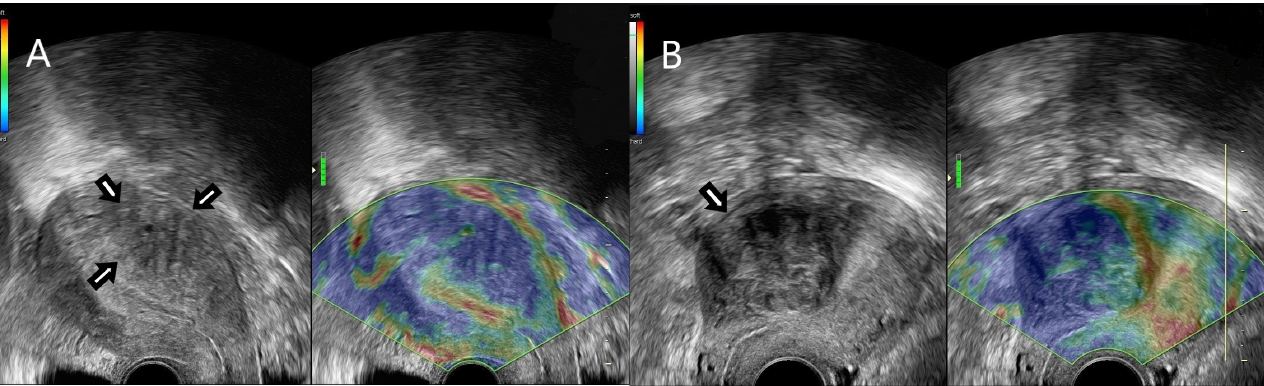
Figure 2. ( A ) Strain ratio elastography assessment of a real time dual mode TVUS image depicting an adenomyotic lesion. ( B ) Strain ratio elastography assessment of a real-time dual-mode TVUS image depicting a uterine